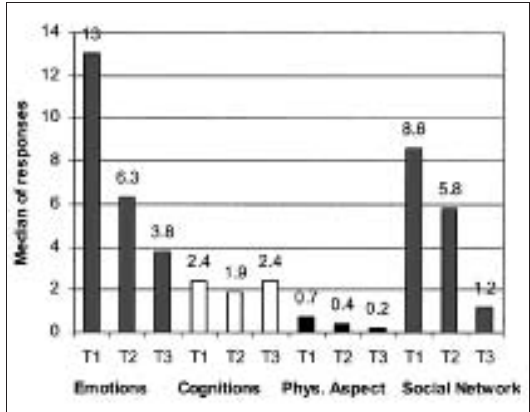
Figure 1 Median of responses per person for the four response-cate- gories (emotions, cognitions, physical aspect, social net- work) at time point 1–3 (T1 = hospitalisa- tion, T2 = 6 months after the loss, T3 = 3.5–6.5 years after the